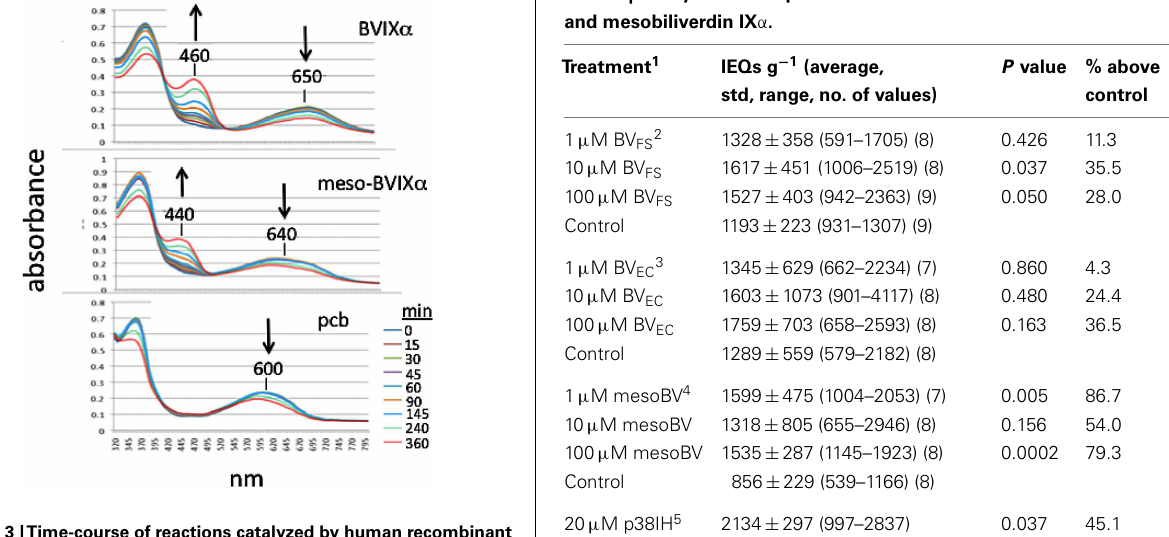
FIGURE 3 |Time-course of reactions catalyzed by human recombinant NADPH biliverdin reductase with E. coli produced biliverdin IX α -HCl (BVIX α ), mesobiliverdin IX α (meso-BVIX α ), and phycocyanobilin (pcb) as substrates. NADPH-dependent reduction was monitored spectrophotometrically for 6h.